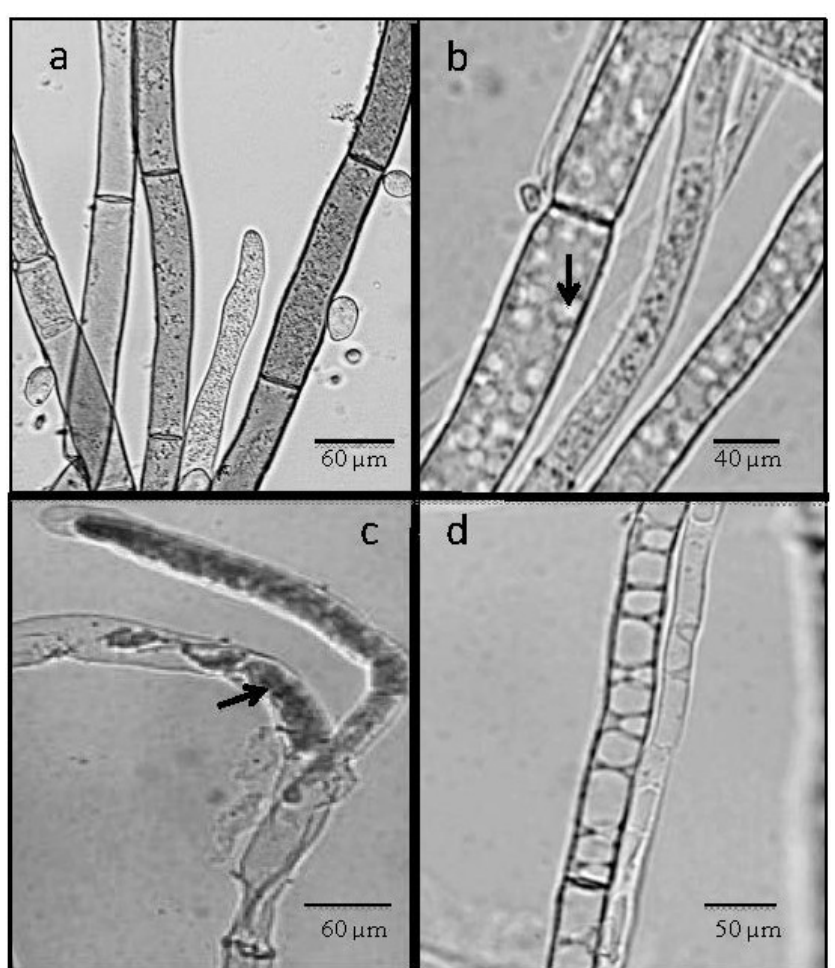
Figure 2. Cytological effects of U. atrum on B. cinerea . ( a – c ): Control mycelium; The cytoplasm of non-treated B. cinerea is usually densely packed with organelles ( a ); In some cases; ( b – d ): Mycelium sampled from the zone of interaction between B. cinerea and U. atrum showed the presence of large vesicles appeared in cells of the mycelium ( b ); In other cases, B. cinerea mycelium showed coagulated cytoplasm ( c ), or an empty mycelium devoid of cytoplasm ( d